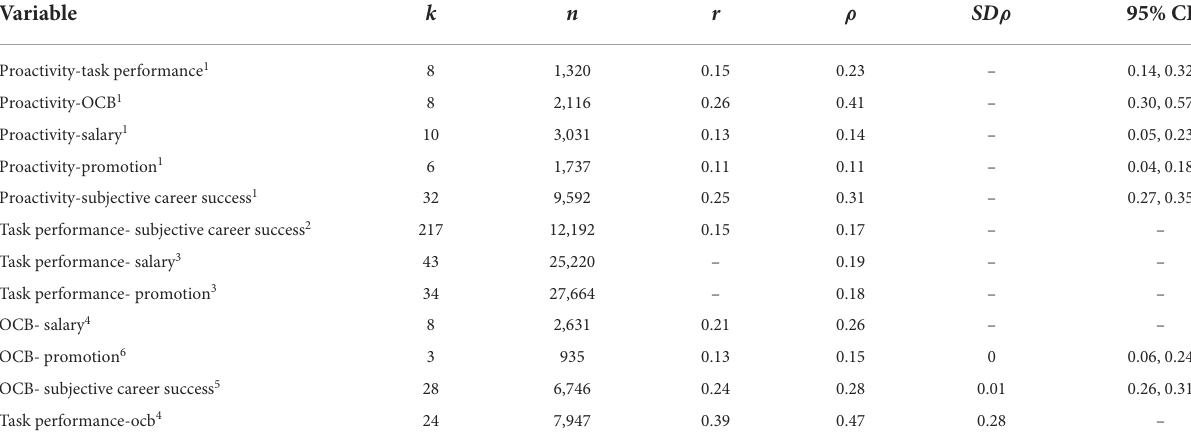
TABLE 1 Meta-analytic correlation required for mediation analysis.